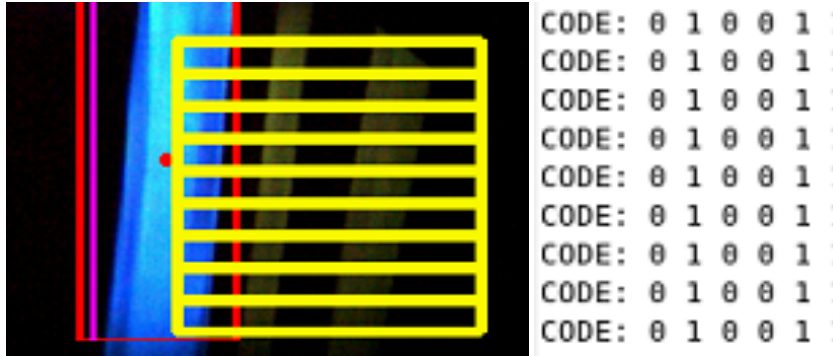
Figure 5. Single frame voting process for the detection of visual